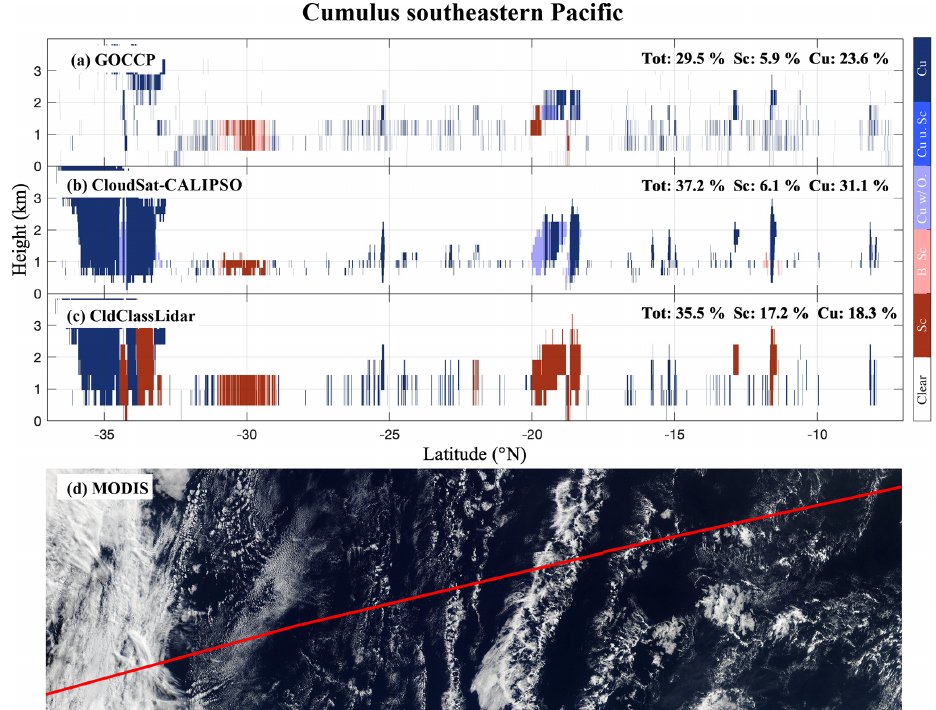
Figure 9. Same as Fig. 6 but for a typical cumulus case in the southeastern Pacific ( ∼ 37 to 8 ◦ S, 8 July 2008 21:47:30, daytime).